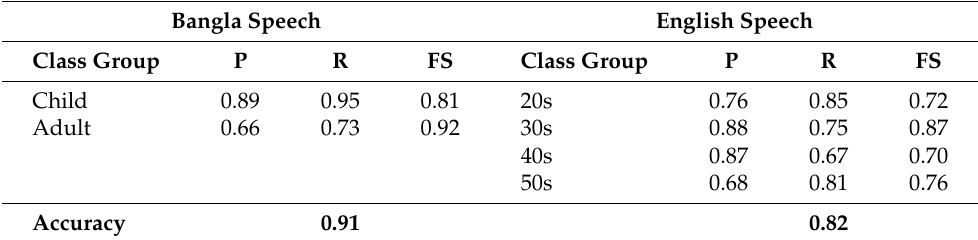
Figure 7. Confusion matrices of dialects for Bangla and English speech. Table 6. Classification Results of Age for Bangla and English Speech Precision (P), Recall (R), and f1-score (FS) using the SCAE-MLELMs